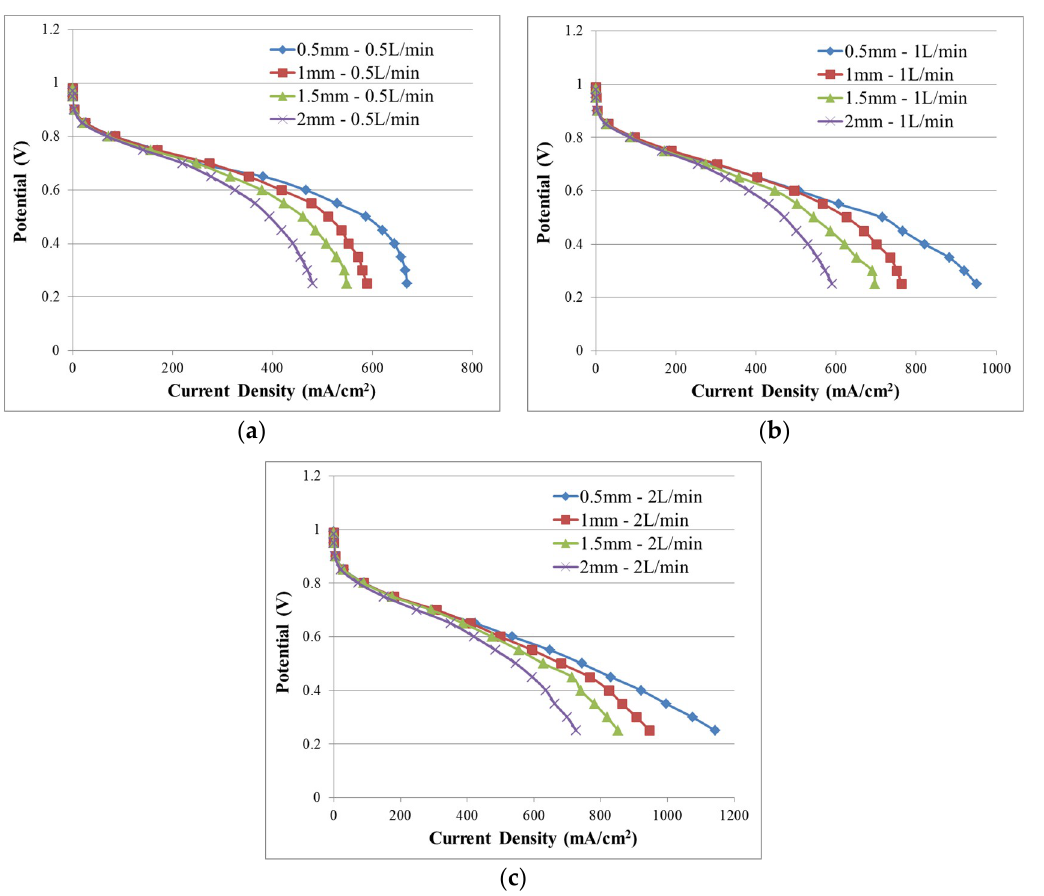
Figure 5. Comparison of polarization curves at different land widths: ( a ) Inlet flow rate = 0.5 L/min; ( b ) inlet flow rate = 1 L/min; ( c ) inlet flow rate = 2 L/min.